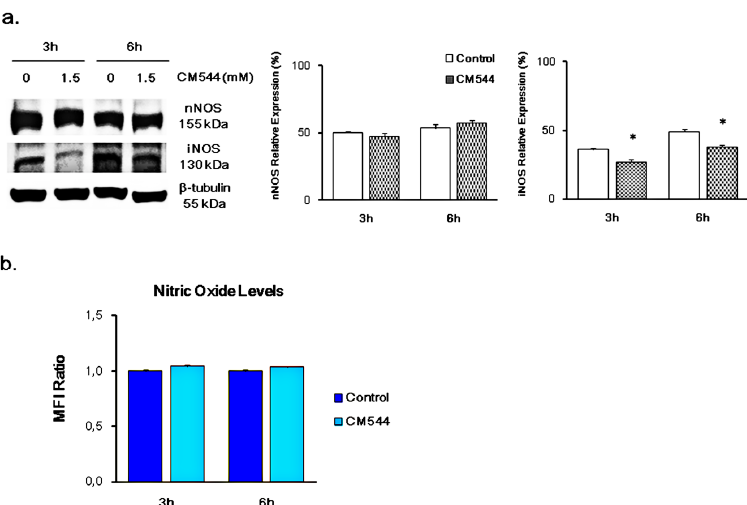
Figure 3. Expression of iNOS and generation of NO in C6 rat glioma cells in the presence of CM544. ( a ) Representative protein bands of iNOS obtained by Western blot analysis. β -tubulin expression was used as protein content marker. Results from one of three independent experiments are shown. Densitometric values are expressed as percentages of the integrated optical intensity of iNOS bands normalized on β -tubulin. * p < 0.05 treated vs. Control. ( b ) Bars represent median values ( ± SD) calculated from individual histograms ( n = 3). Values are expressed as the MFI Ratio of the control (untreated cells).